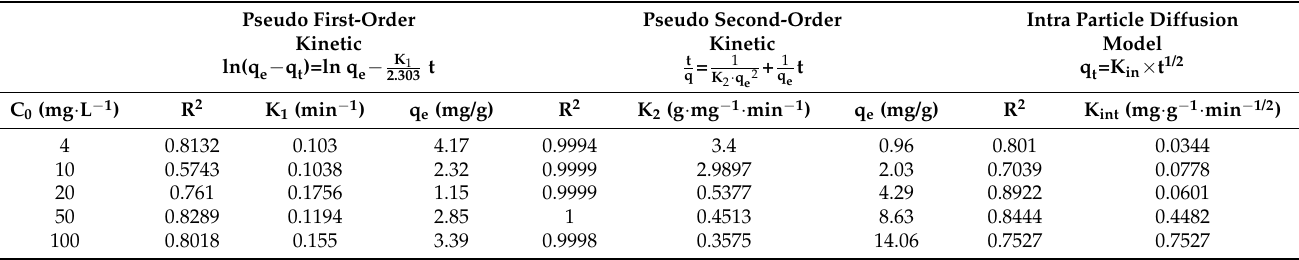
Table 5. Kinetic parameters for the adsorption of BR dye onto ALP.